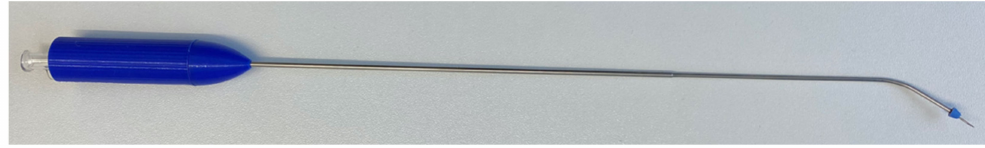
Figure 1. Injection instrument with the retractable cannula being pushed